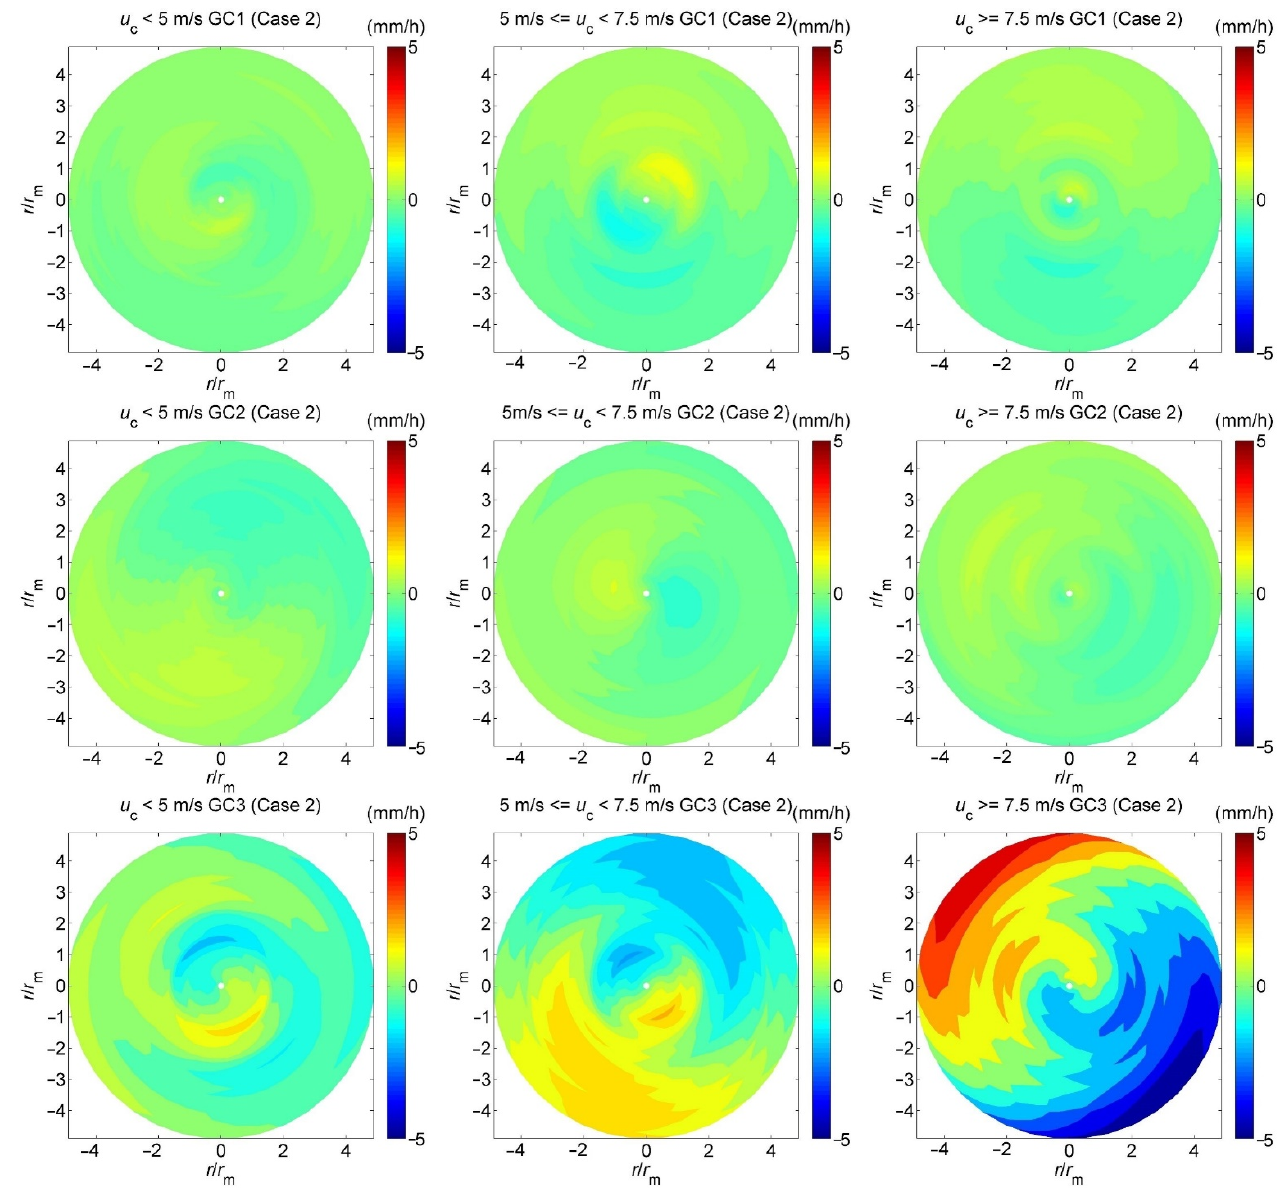
Figure 7. Asymmetric rainfall fields calculated based on the model coefficients shown in Figure 5 for Case 2. Table 3. Parameters for the statistics of the residuals.